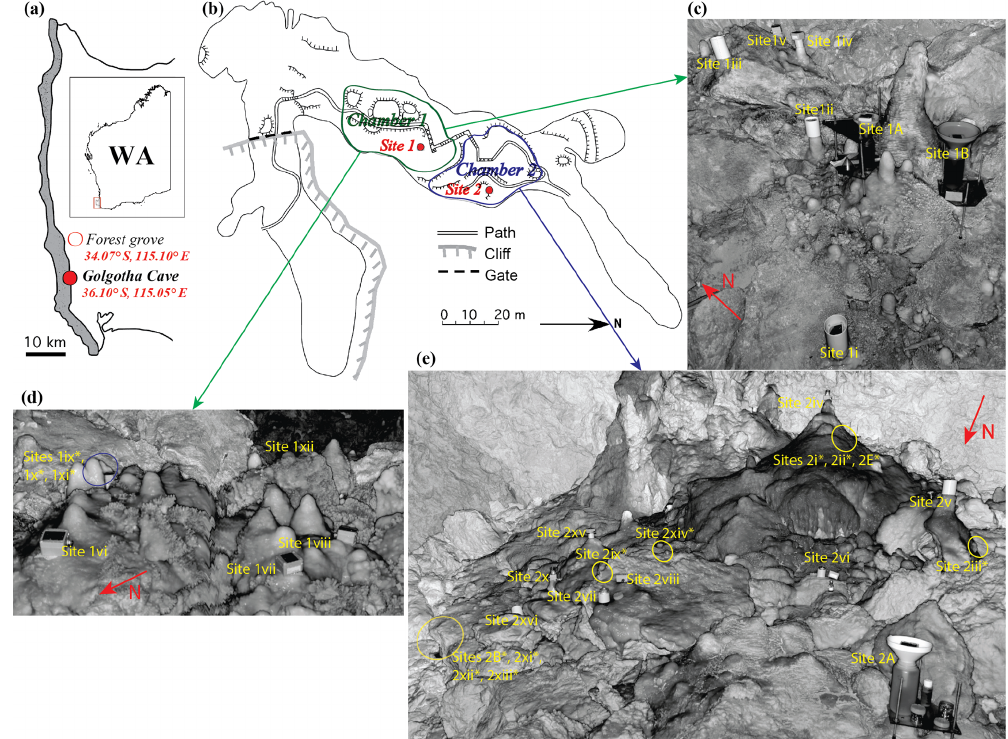
Figure 1. (a) Coastal belt of SWWA (southwest Western Australia). (b) Golgotha Cave plan view displaying both Chamber 1 (green marked area), which comprises Site 1, and Chamber 2 (blue marked area) containing Site 2. Average limestone thickness from cave ceiling to ground surface over Site 1 and 2 is 32.33 and 40.24m, respectively. Lidar scans of drip sites on (c) Chamber 1 north floor, (d) Chamber 1 south floor, and (e) Chamber 2 floor. The red arrows show the geographic orientation (c, d, e) . ∗ indicates the sites where the stalagmite loggers are not clearly visible in the lidar floor images as they are obscured by formations in front of them, however the approximate locations are marked with yellow circles. Additional scans of cave ceiling and photographs of underlying stalagmites are shown in Fig. 3 of Mahmud et al.